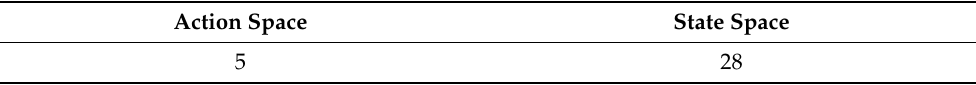
Table 1. Table of action space and state space size settings in MDP. There are five actions, so the action space is 5. The sum of all dimensions of the state is 28, so the state space size is 28.